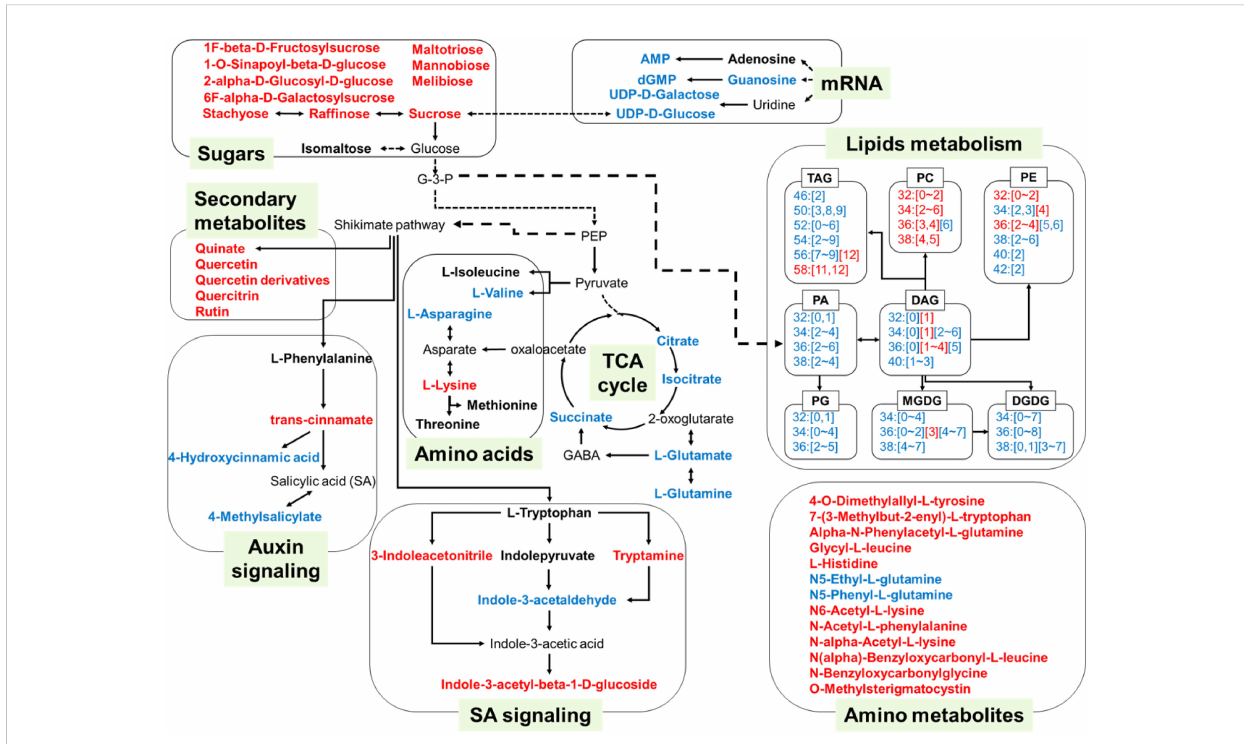
FIGURE 7 A model illustrating the main alteration of metabolites and lipids during seed germination under heat stress. The metabolites and lipids are implicated in TCA cycle, amino acids metabolism, sugar metabolism, lipids metabolism, secondary metabolites, phytohormone SA and auxin signaling, mRNA transcription during seed germination and seedling growth under heat stress. The metabolites shown in red font indicated signi fi cantly increased levels, and shown in blue font indicated the decreased levels under the temperatures of 34°C and 40°C, compared with those under the temperatures of 22°C and 28°C. Lipids were presented as number of carbon atoms and unsaturation degrees. Numbers in bracket were the unsaturation degrees of fatty acyl